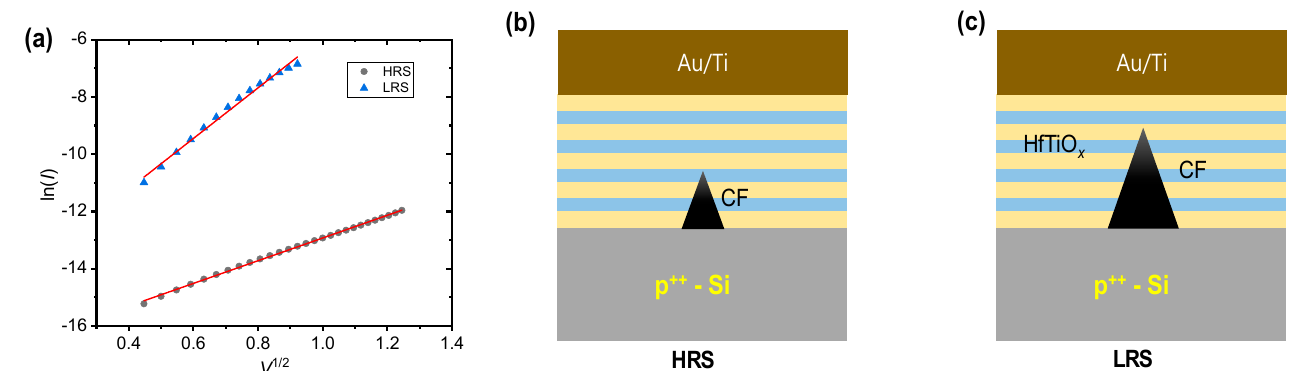
Figure 7. ( a ) ln( I ) versus V 1/2 fitting curve of Au/Ti/HfTiO x /p-Si device in the LRS and HRS. ( b ) Filament evolution and gap region between Au/Ti and filament in ( b ) HRS and ( c ) LRS.